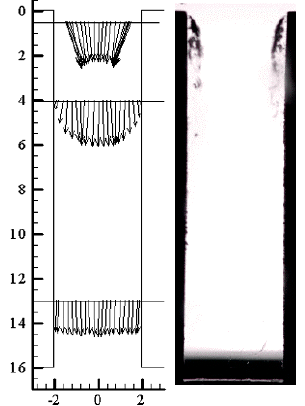
Fig. 6 Time-averaged liquid velocity distribution in the 2D nozzle ( W N = 4 mm) (12)